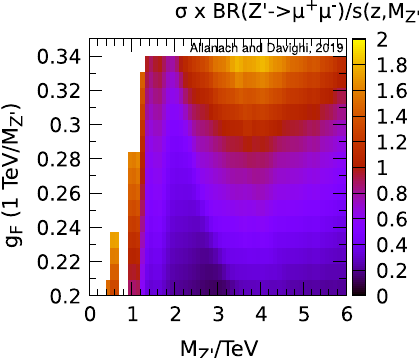
Fig. 4 σ × BR ( Z (cid:2) → μ + μ − ) divided by its upper limit from the ATLAS direct search in the DTFHMeg. We do not plot any points where this ratio is larger than two, leading to the white regions on the left-hand side of the figure (which correspond to excluded parameter space) Table 3 Example point in the DTFHMeg parameter space, ( g , M ) = ( 0 . 81 , 3 TeV ) . We display the fiducial production cross- F Z (cid:2) sectiontimesbranchingratiointodi-muonsas σ .Byfarthedominant13 TeVLHCproductionmodeis b ¯ b → Z (cid:2) (thenextlargest, b ¯ s + s ¯ b → Z (cid:2) , yields σ = 6 . 1 × 10 − 5 fb) (cid:18)/ M σ /fb BR BR BR BR Z (cid:2) ( Z (cid:2) → μ + μ − ) ( Z (cid:2) → t ¯ t ) ( Z (cid:2) → b ¯ b ) ( Z (cid:2) → τ + τ − ) 0.087 0.046 0.11